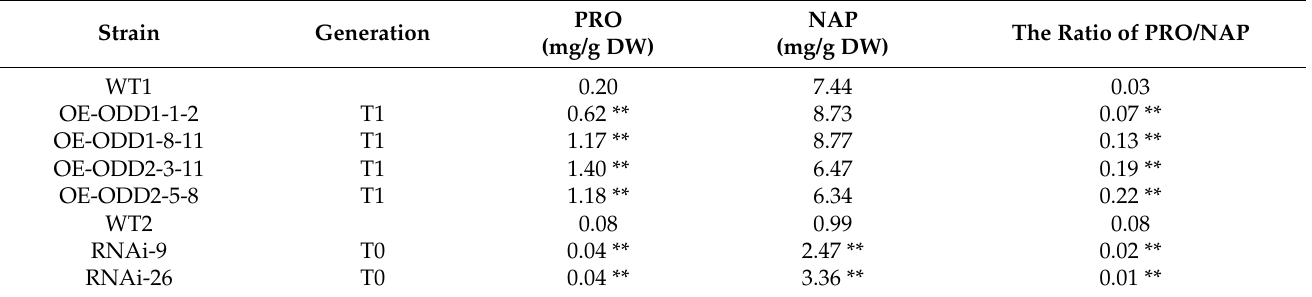
Table 1. The content of glucosinolates of BocODD1/2 transformed